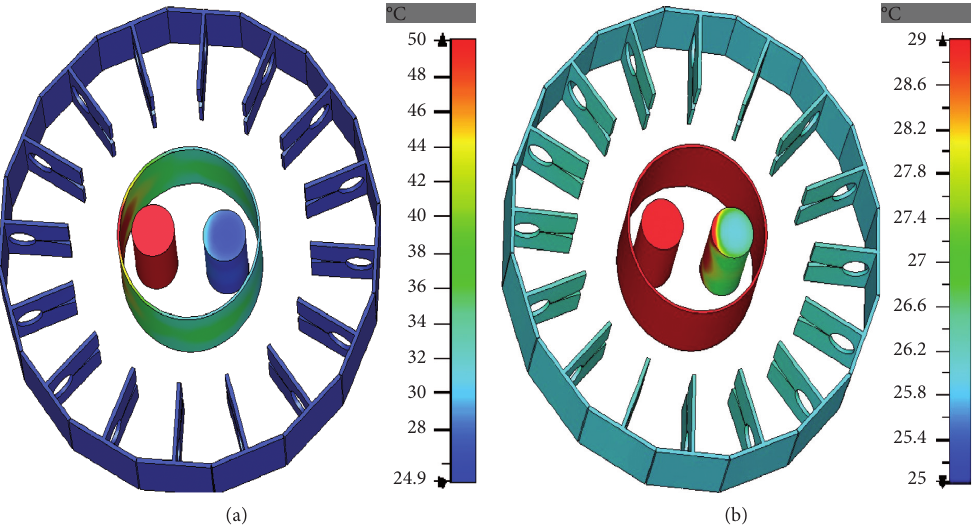
Figure 7: Temperature distribution with (a) 50 ° C and (b) 29 ° C maximum